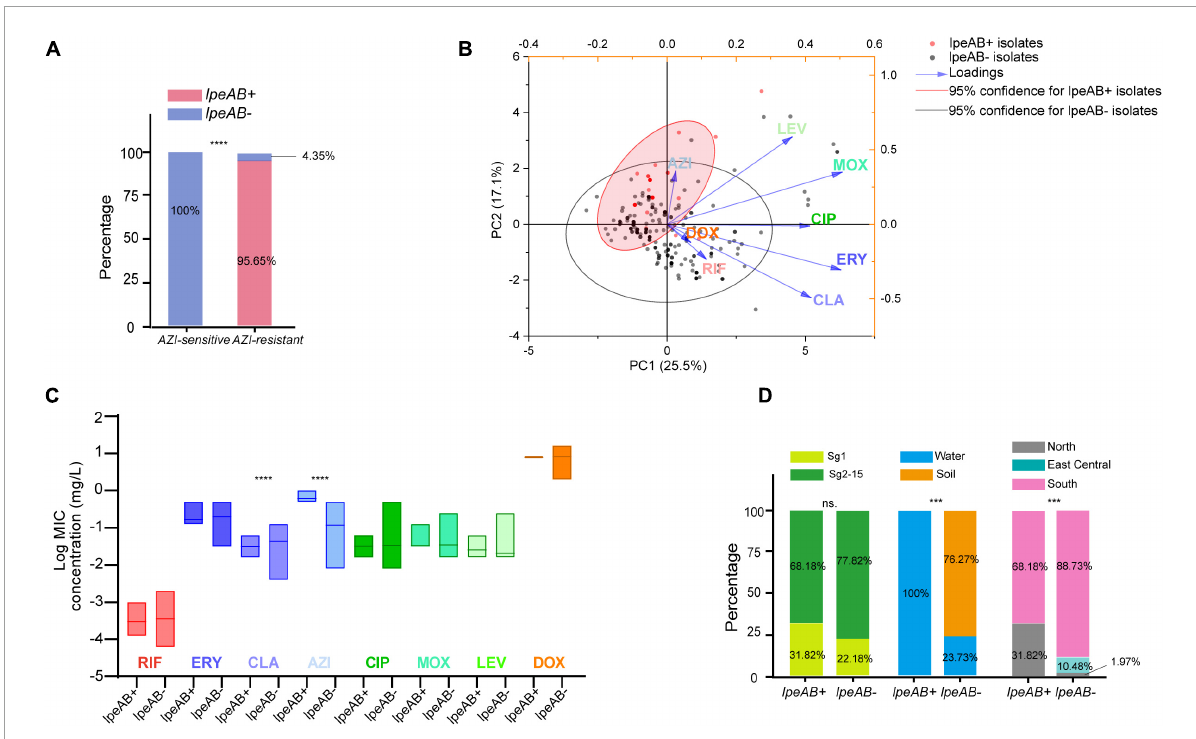
FIGURE6 Presence of lpeAB efflux in L. pneumophila and its distribution in the isolates belonging to different sgs or from different sources and regions in China. (A) Presence of lpeAB efflux in AZI-sensitive and –resistant isolates. (B) PCA biplot of indices of the isolates harboring or not harboring lpeAB efflux. Isolates are shown as dots and colored by groups based on the presence of lpeAB efflux. Indices showed as lines with arrows and colored. The configuration of indices in the biplot represented the relationship between variables and principal components. The red shadow indicates 95% confidence for lpeAB + isolates. (C) Average MICs between isolates with or without lpeAB efflux. Data are shown as floating bars with the max and min and mean values. (D). Different distribution patterns of lpeAB in the isolates belonging to different sgs or from different sources and regions of China. *** P < 0.001, **** P <